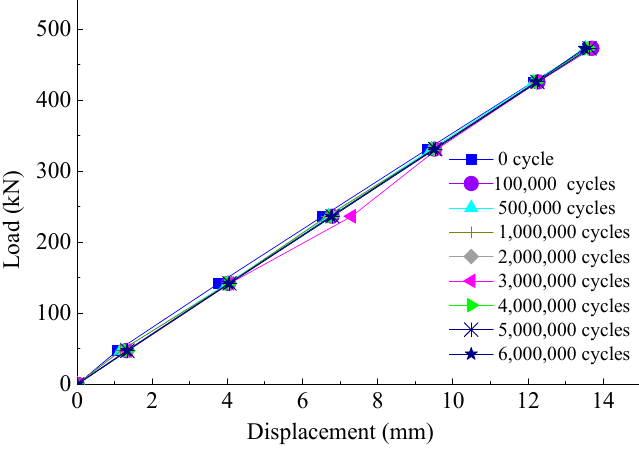
Figure 12. Static load-displacement curve at midspan.